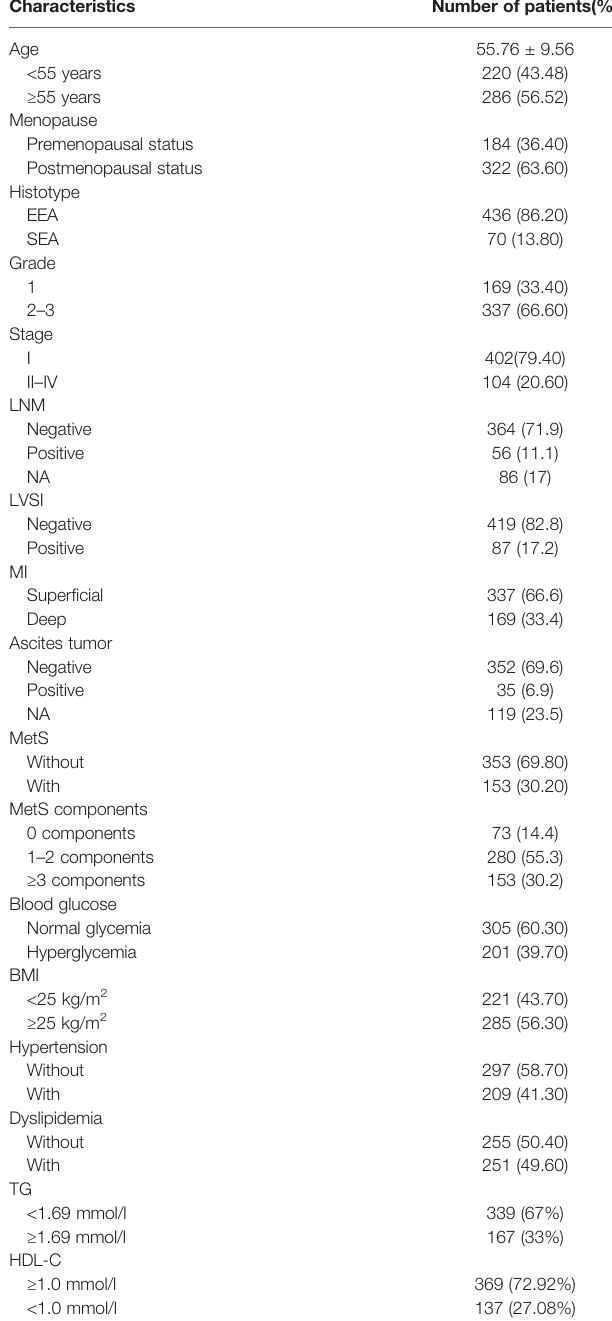
TABLE 1 | Clinical and pathological characteristics for 506 EC patients.